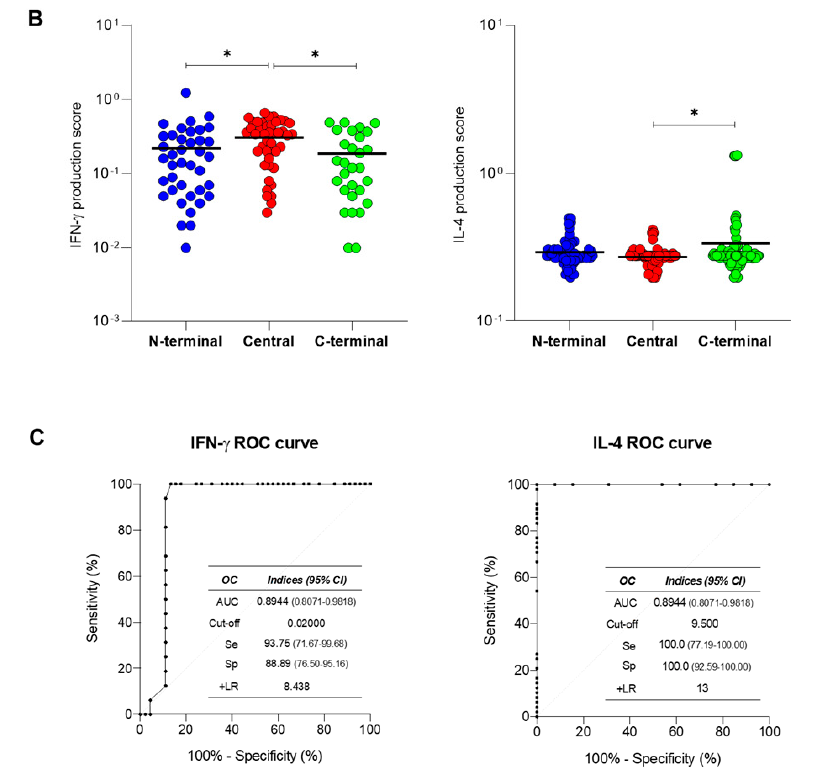
Figure 5. In silico analysis of the functional features of reactive HLA-A*02:01-restricted Tax peptides. Proinflammatory (IFN- γ ) and regulatory (IL-4) cytokine profile of HLA-A*02:01-reactive peptides distributed along the N-terminal, Central and C-terminal regions of Tax. ( A ) Percentage of IFN- γ and IL-4 inducing and non-inducing peptides using 1 and 10 µg/mL of the HLA-A*02:01 haplotype. ( B ) Pro-inflammatory and regulatory cytokine production scores. ( C ) Analysis of sensitivity and specificity parameters using ROC curve analysis based on IFN- γ and IL-4 production scores. Connecting lines with asterisks show statistical differences at p < 0.05 (* indicates p ≤ 0.05).